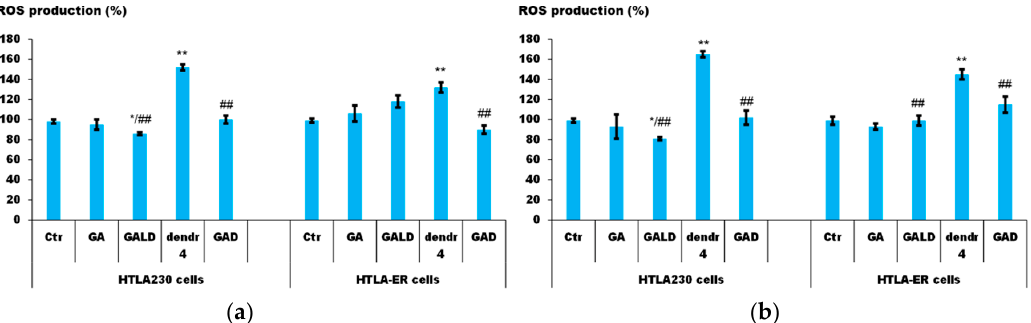
Figure 13. ROS levels in HTLA-230 and HTLA-ER cells treated with GA, GALD, and GAD. ROS generation was analyzed in HTLA-230 and HTLA-ER cells exposed to dendrimer 4 at the known active concentration (0.169 µM), to GALD (in a dose capable of providing 0.169 µM dendrimer 4 ) to 21.20 µM GA (the dose provided by GALD used), and GAD in a dose capable to provide 21.20 µM GA for: 48 h ( a ); and 72 h ( b ). Histograms summarize quantitative data of the means ± S.E.M. of three independent experiments. ** p < 0.01 vs. Ctr cells; ## p < 0.01 vs. dendrimer 4 -treated cells; * p < 0.05 vs. GA-treated cells.